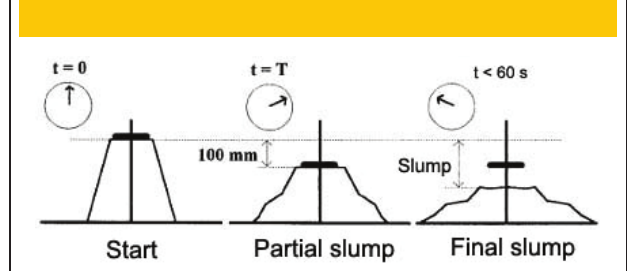
Figure 3 – Design of the modified slump